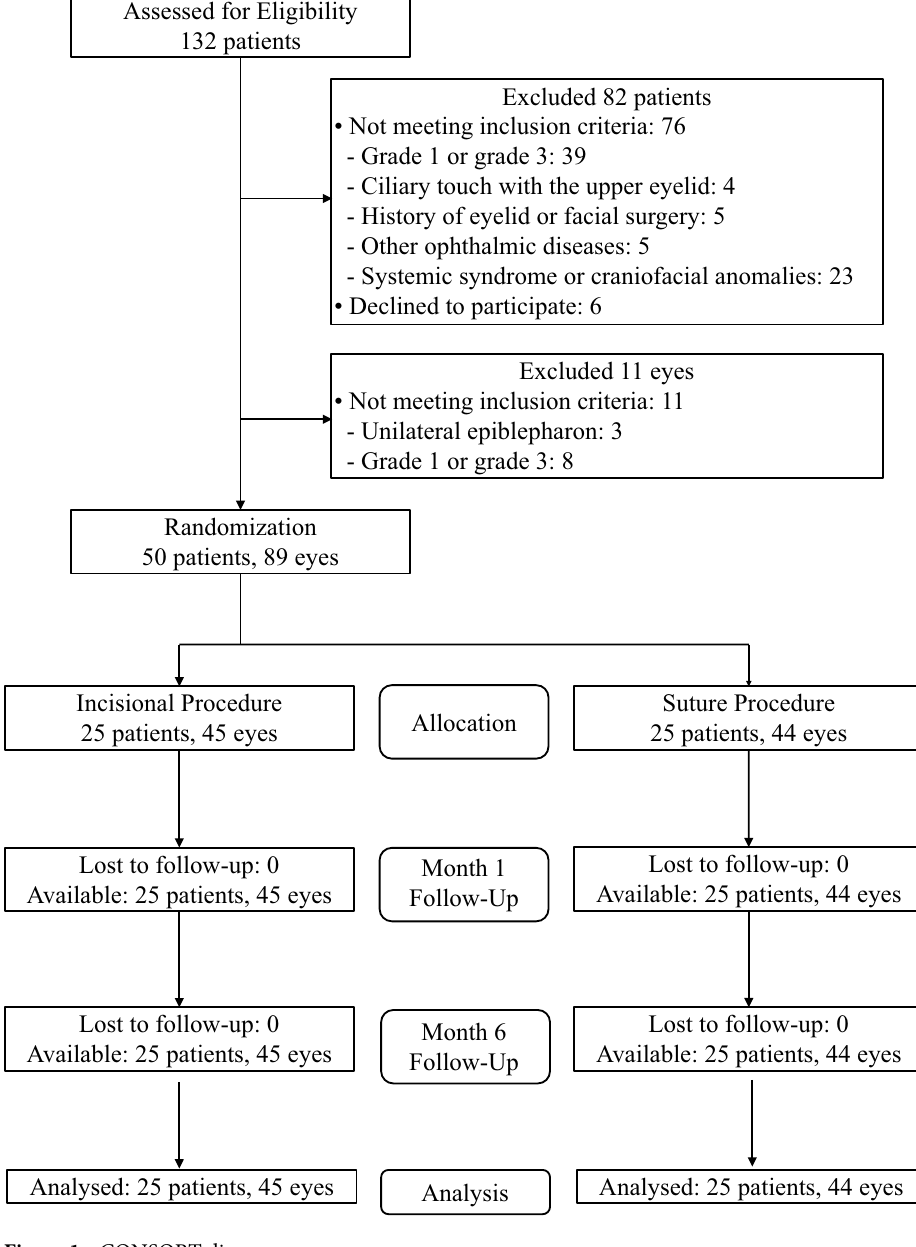
Figure 1. CONSORT